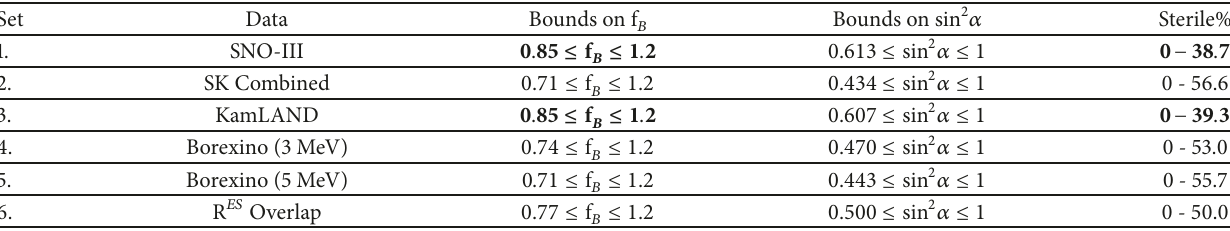
Table 6: Results from sin 2 𝛼 -f 𝐵 degeneracy